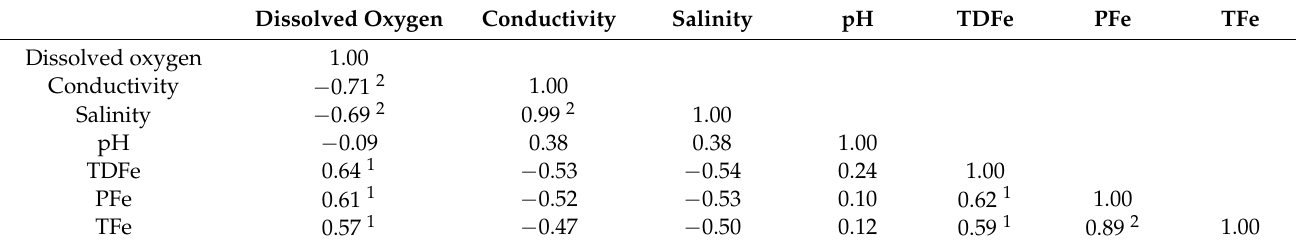
Table 3. Pearson’s correlation matrix for different Fe fractions and the physical and chemical parameters of the water sample.